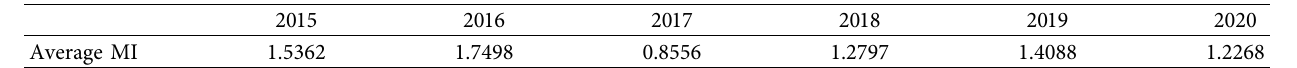
Figure 1: Colormaps of the MI among the 12 provinces during the six years. (a) 2015. (b) 2016. (c) 2017. (d) 2018. (e) 2019. (f) 2020. Table 3: Average MI between regional indexes in the six years,